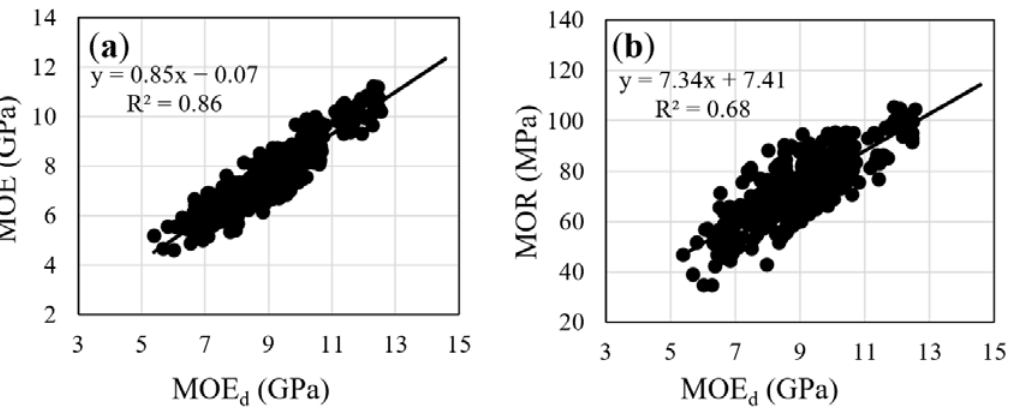
Figure 5. Relationship between air-dry density (SWV S ) and static properties: ( a ) modulus of elasticity (MOE) and ( b ) modulus of rupture (MOR) for all clones.